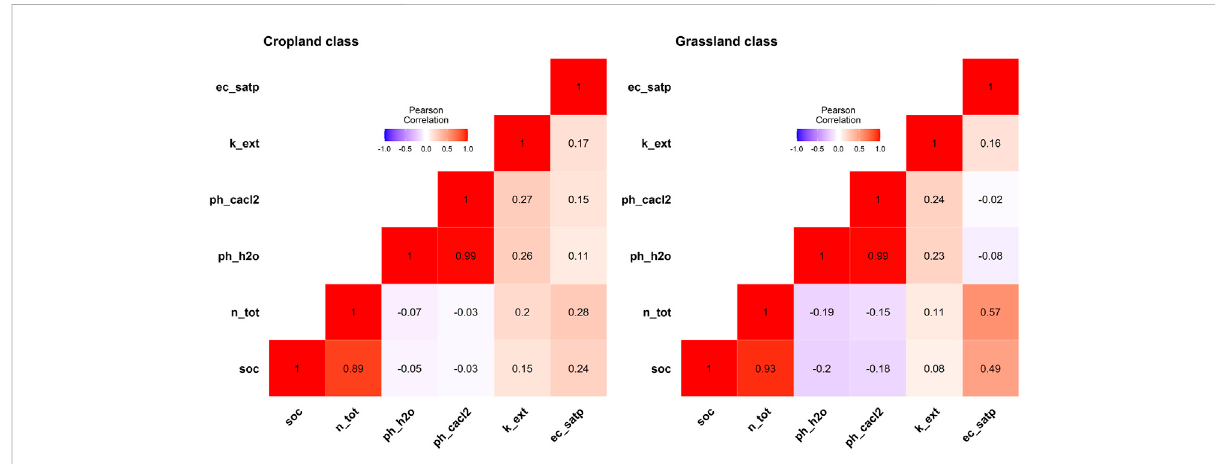
FIGURE 4 Correlation matrix as a heatmap between explanatory variables and soil organic carbon per land cover